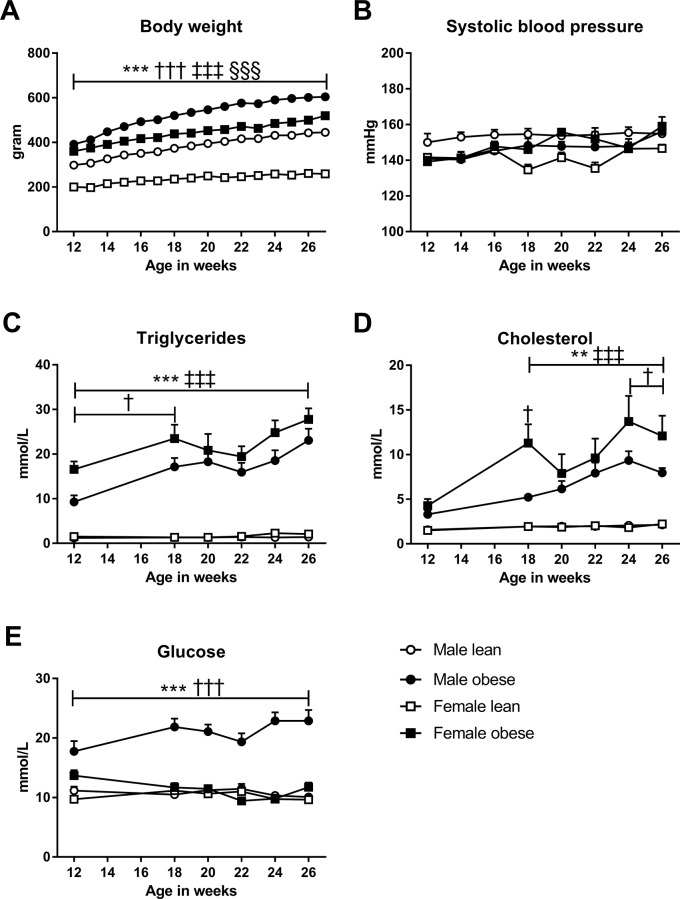
Both male and female obese ZSF1 rats exhibit obesity, dyslipidemia and mild hypertension.A) Body weight was markedly higher in the obese ZSF1 rats compared to their lean counterparts. B) Systolic blood pressure was similar in all the groups, with a range of 140–150 mmHg over time. C) Triglycerides and D) cholesterol levels were markedly elevated in both male and female obese ZSF1 rats. E) Plasma glucose levels were only elevated in male obese rats compared to their lean counterparts. Means ± SEM. Male obese N = 9; female obese N = 8; male lean N = 8 and female lean N = 6; * male obese vs. male lean; † male obese vs. female obese; ‡ female obese vs. female lean; § male lean vs. female lean. One symbol P<0.05, two symbols P<0.01, three symbols P<0.001.